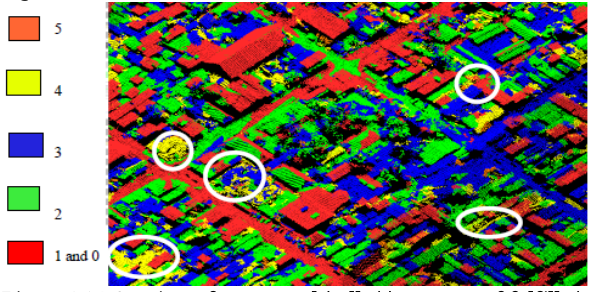
Figure 4 ALS points of segments labelled by counts of fulfilled conditions. White circles indicate regions with seg- ments classified as collapsed buildings (labels 4 and 5).